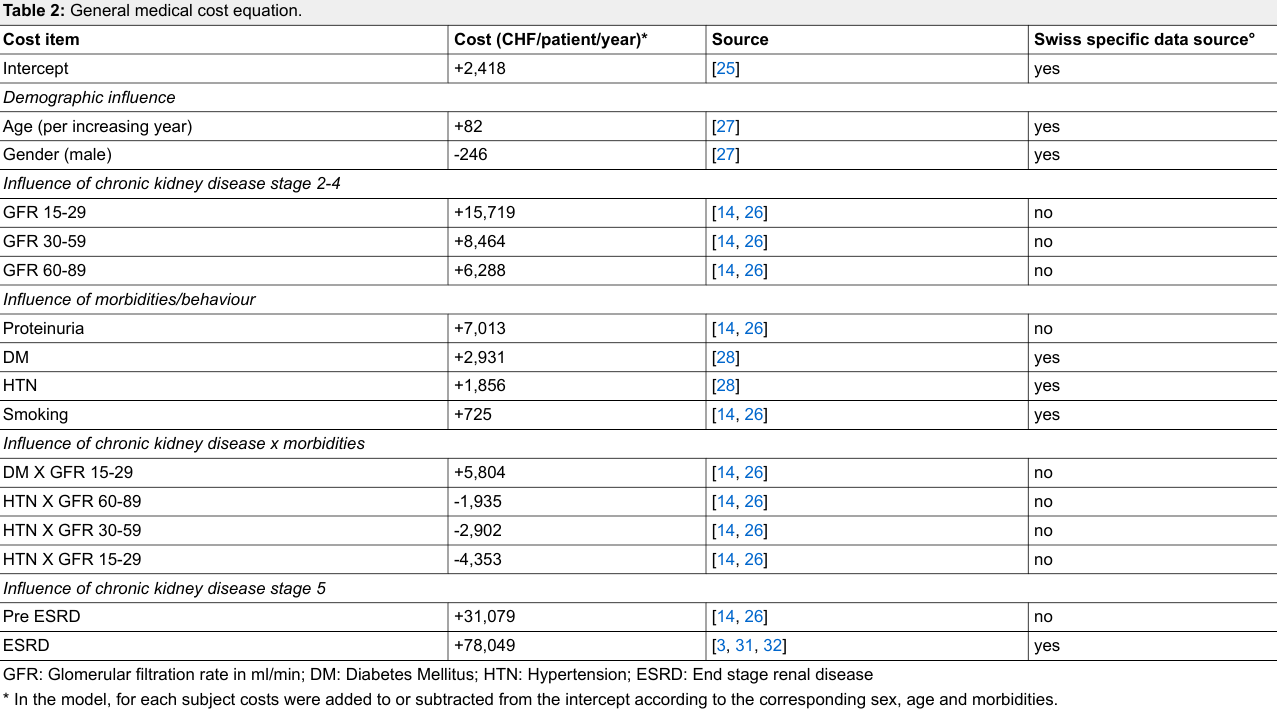
Table 2: General medical cost equation.